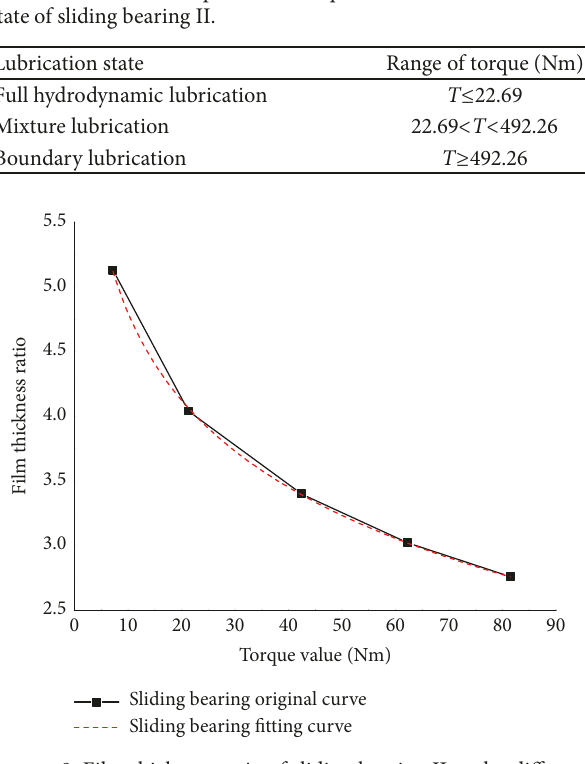
Figure 9: Film thickness ratio of sliding bearing II under different torque